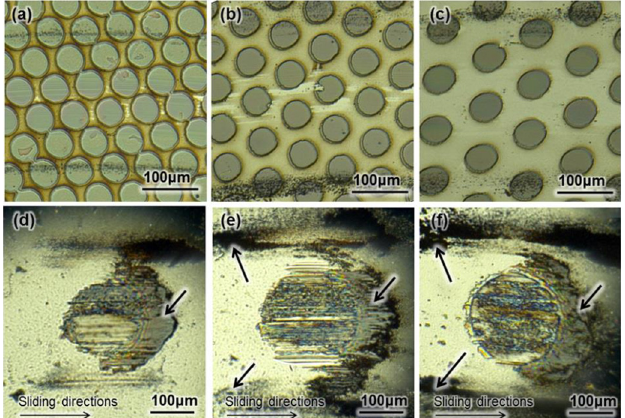
Fig. 10. Optical surface images of wear tracks of micro-textured DLC fi lms with different texture interspace of 15 m m (a), 30 m m (b), 50 m m (c) as well as the corresponding counterparts of SUJ2 balls (d – f), respectively, after the 30 000 laps of ball-on-disk friction tests.